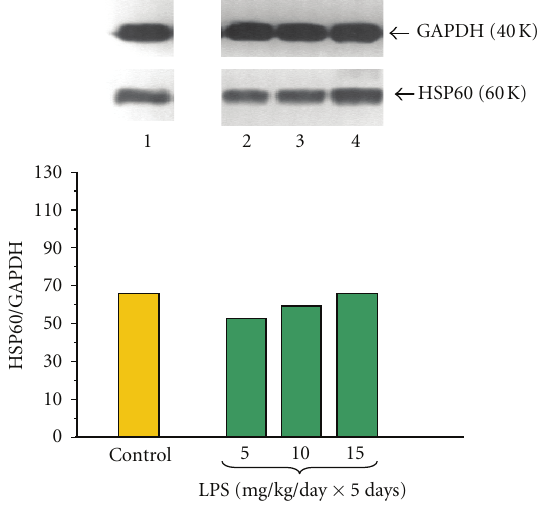
Figure 9: Western blot analysis of HSP60 protein level in the adult rat pancreatic acinar cells under basal conditions (lane 1), stimulated in vitro by caerulein at the dose of 10 − 8 M (lane 2), treated in the infant animals by lipopolysaccharide ( Escherichia coli ) at the doses of 5mg/kg/day × 5 days + caerulein 10 − 8 M (lane 3), 10 mg/kg/day × 5 days + caerulein 10 − 8 M (lane 4), and 15 mg/kg/day × 5 days + caerulein 10 − 8 M (lane 5) after 5 hours of incubation. Cross indicates significant ( P < 0 . 05) change, as compared to the control group. Asterisk indicates significant ( P < 0 . 05) change, as compared to the value obtained from the rats treated by increasing doses of LPS (10 or 15mg/kg/day × 5 days) in combination with caerulein (10 − 8 M), as compared to the caerulein (10 − 8 M) alone stimulation. The blots were stripped and probed with GAPDH to document equal protein loading. All presented results were obtained in 4 consecutive experiments and are representative of the observed